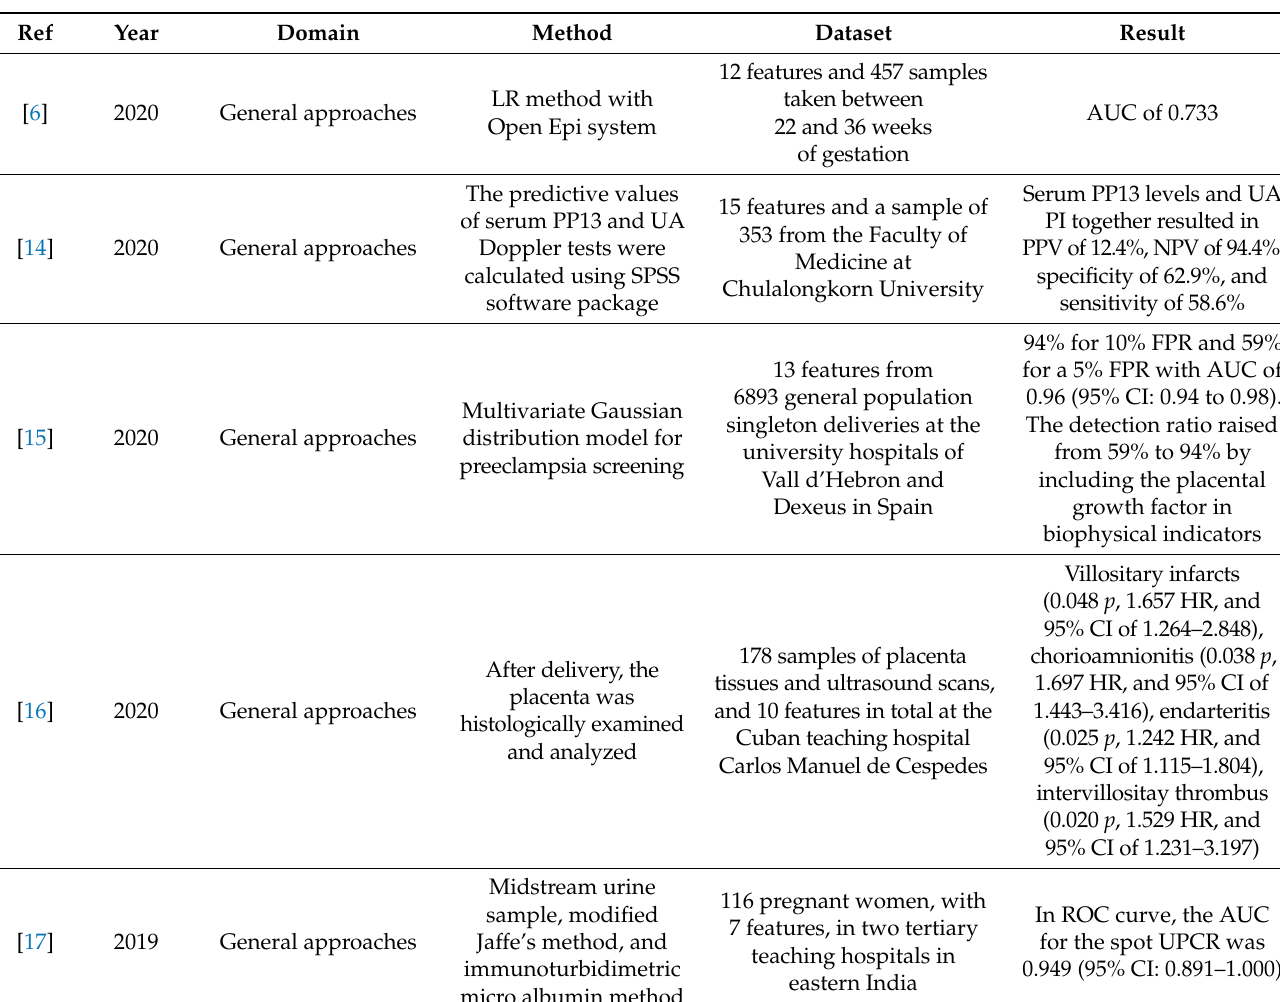
Table 1. Summary of related studies using general